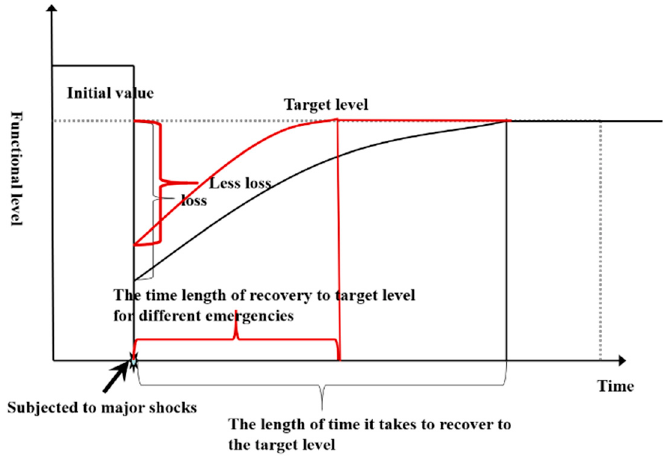
Figure 4. Contrast chart of how different emergencies affect the city safety r esilience